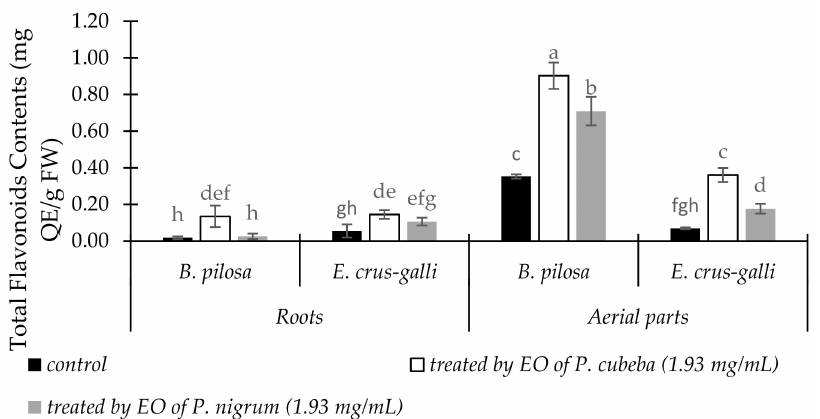
Figure 5. The changes of TFC in the roots and aerial parts of between treated and untreated of B. pilosa and E. crus-galli by P. cubeba and P. nigrum EOs. Data were presented in means ± standard deviations (SD). Means with di ff erent small letter indicted significantly di ff erent by Fisher’s test ( p < 0.05).